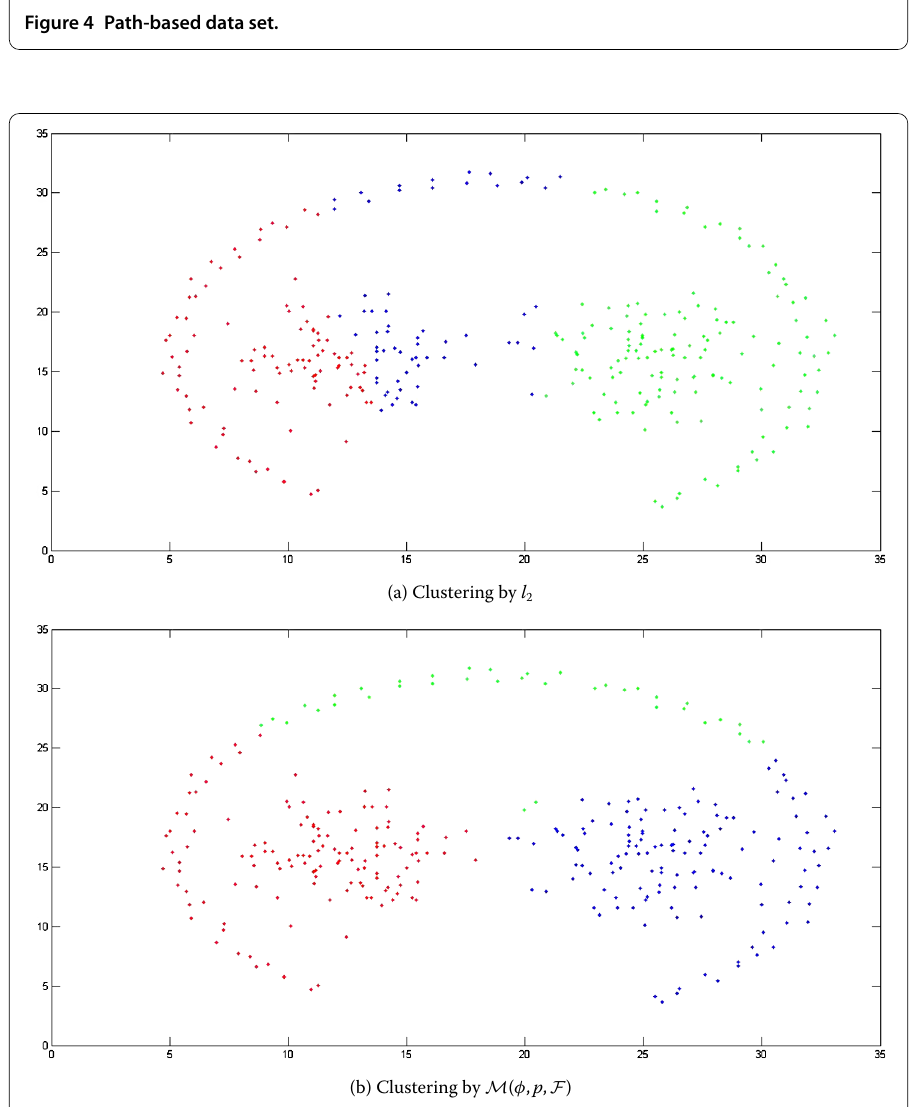
Figure 5 Obtained clustering results for two-moon data